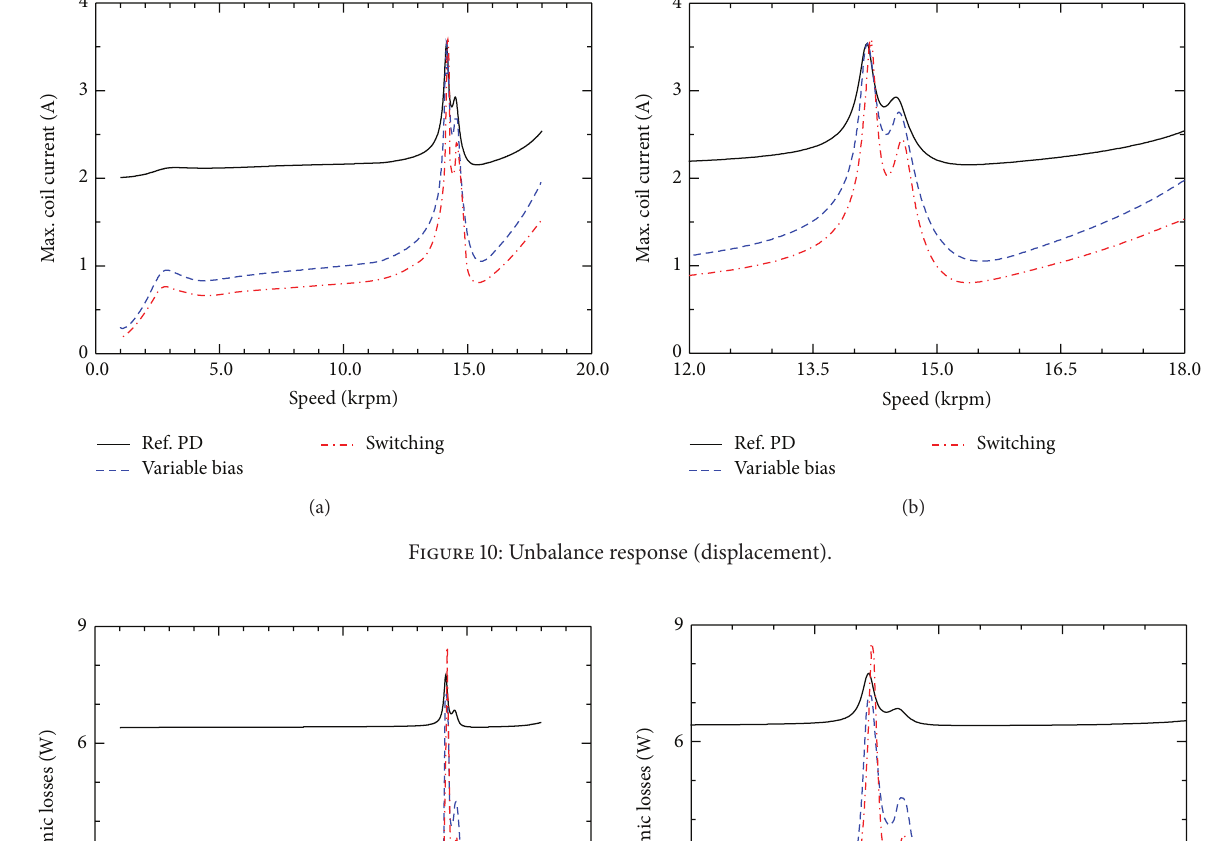
Figure 10: Unbalance response (displacement).